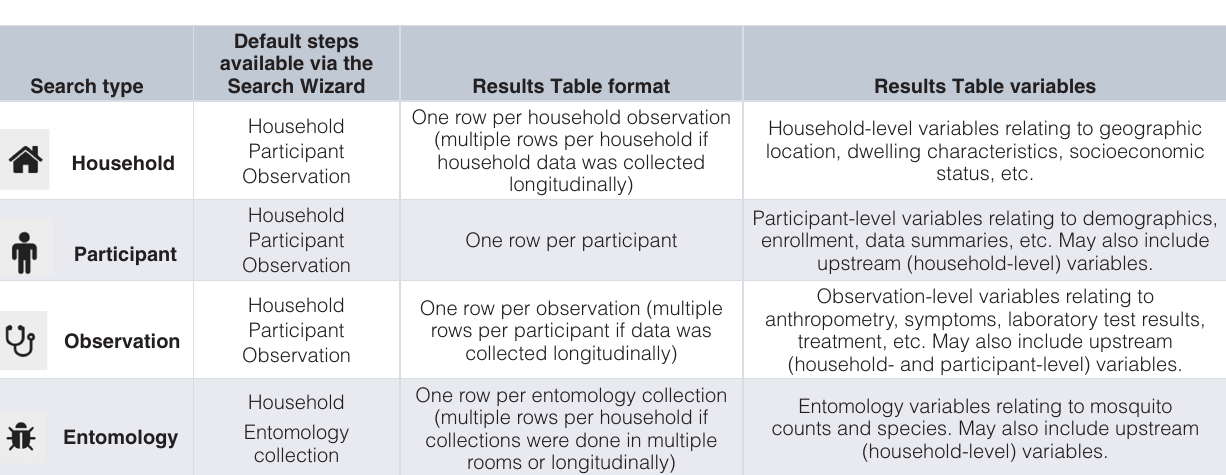
Table 2. Search types currently available in